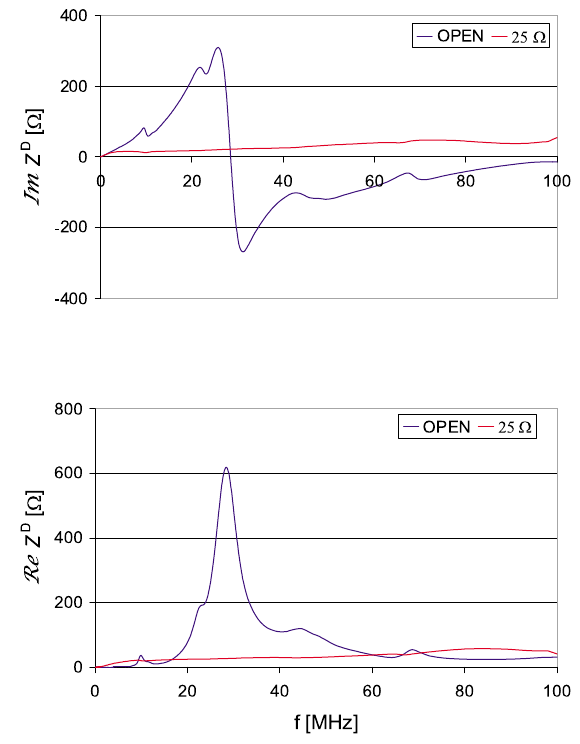
FIG. 8. (Color) Input impedance of the prototype kicker mag- net at the